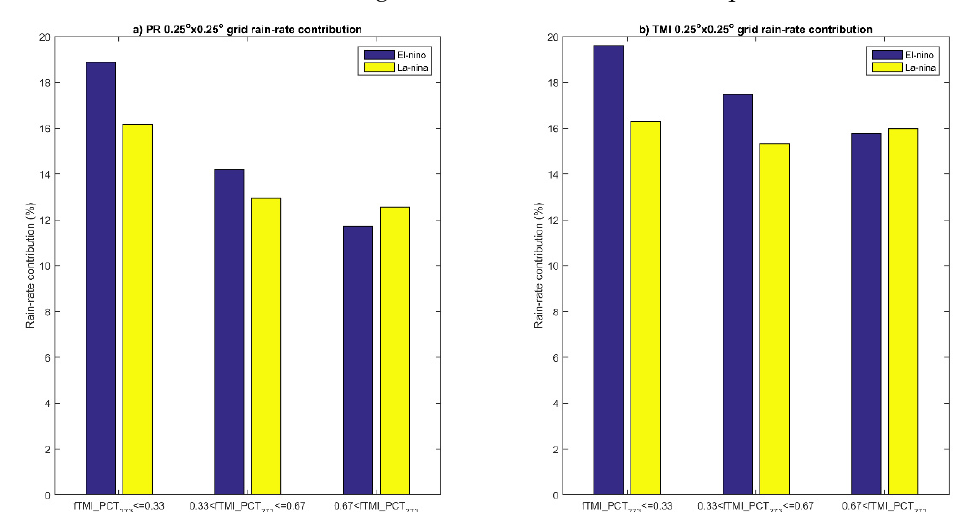
Figure 3. Comparison of PR rain-rate contribution ( a ) and TMI rain-rate contribution ( b ) for shallow precipitation systems during El Niño events in 2007 and La Niña events in 2009 over the global tropical ocean. (Source: data processing).